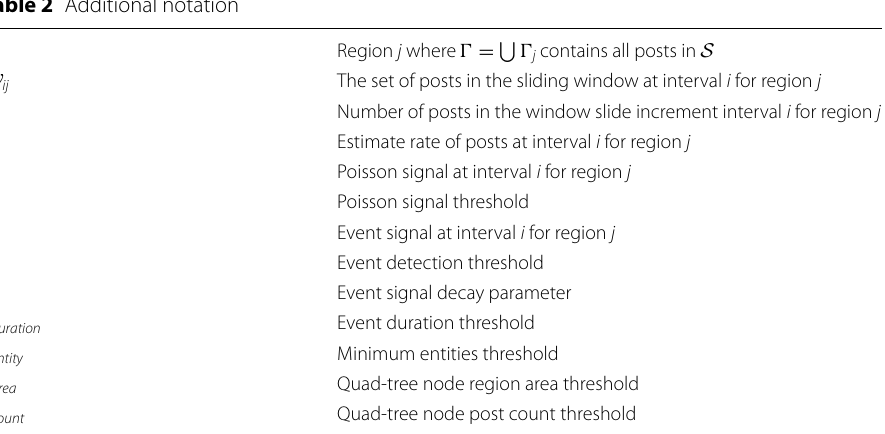
Table 2 Additional